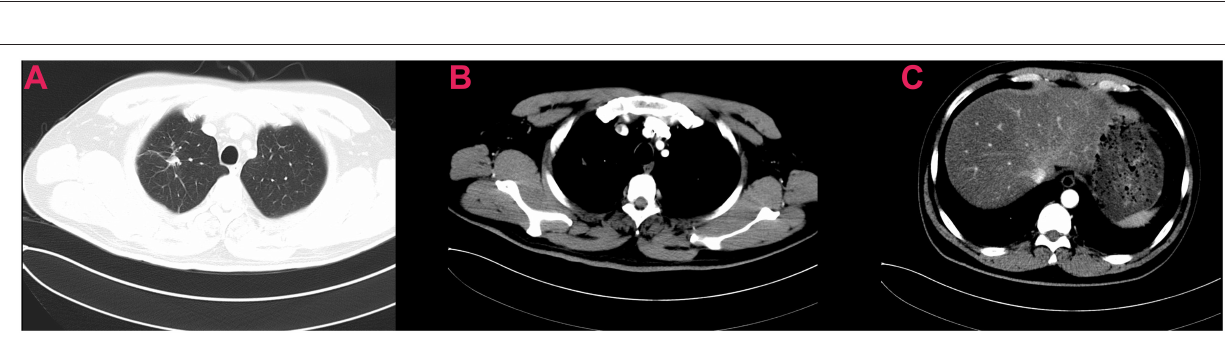
FIGURE 2 | Preoperative chest computed tomography of the patient showing excellent response to neoadjuvant targeted therapy (A–C)